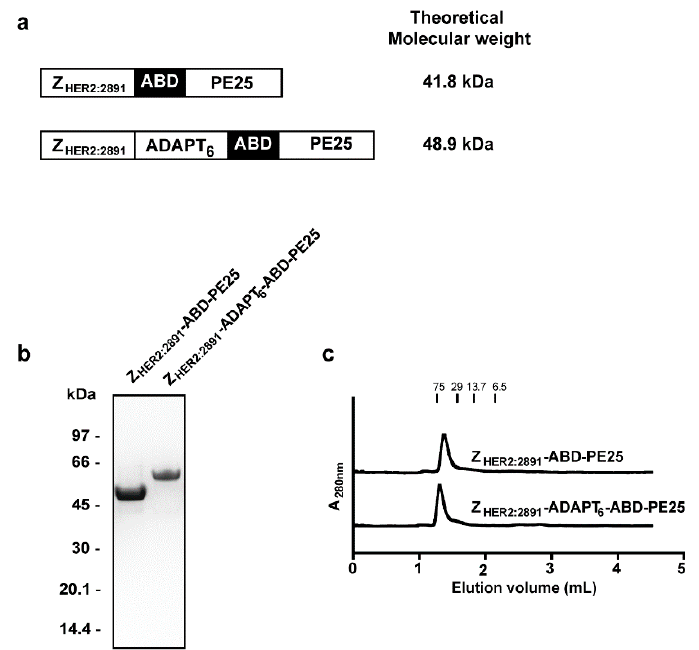
Figure 1. Schematic description and initial biochemical characterization of the fusion toxins. ( a ) A schematic description of the fusion toxins analyzed in the current study along with their theoretical molecular weights. The individual domains of the fusion toxins were connected with linkers with the amino acid sequence (S 4 G) 4 . After purification by affinity chromatography with immobilized human serum albumin (HSA), the fusion toxins were analyzed by sodium dodecyl sulfate–polyacrylamide gel electrophoresis (SDS-PAGE) under reducing conditions ( b ). The numbers to the left indicate molecular weights of reference proteins. The fusion toxins were also analyzed by analytical size exclusion chromatography and the recorded chromatograms are shown in ( c ). The numbers above the chromatograms correspond to elution volumes of reference proteins.